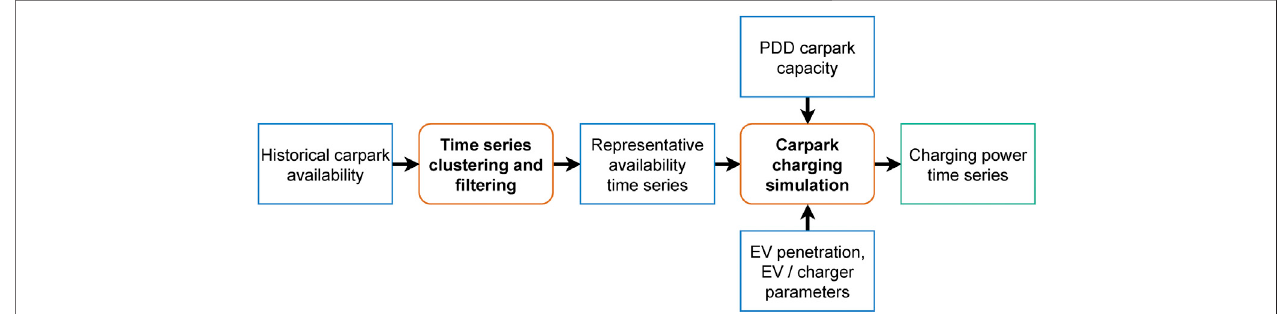
FIGURE 4 | Work fl ow for EV charging demand